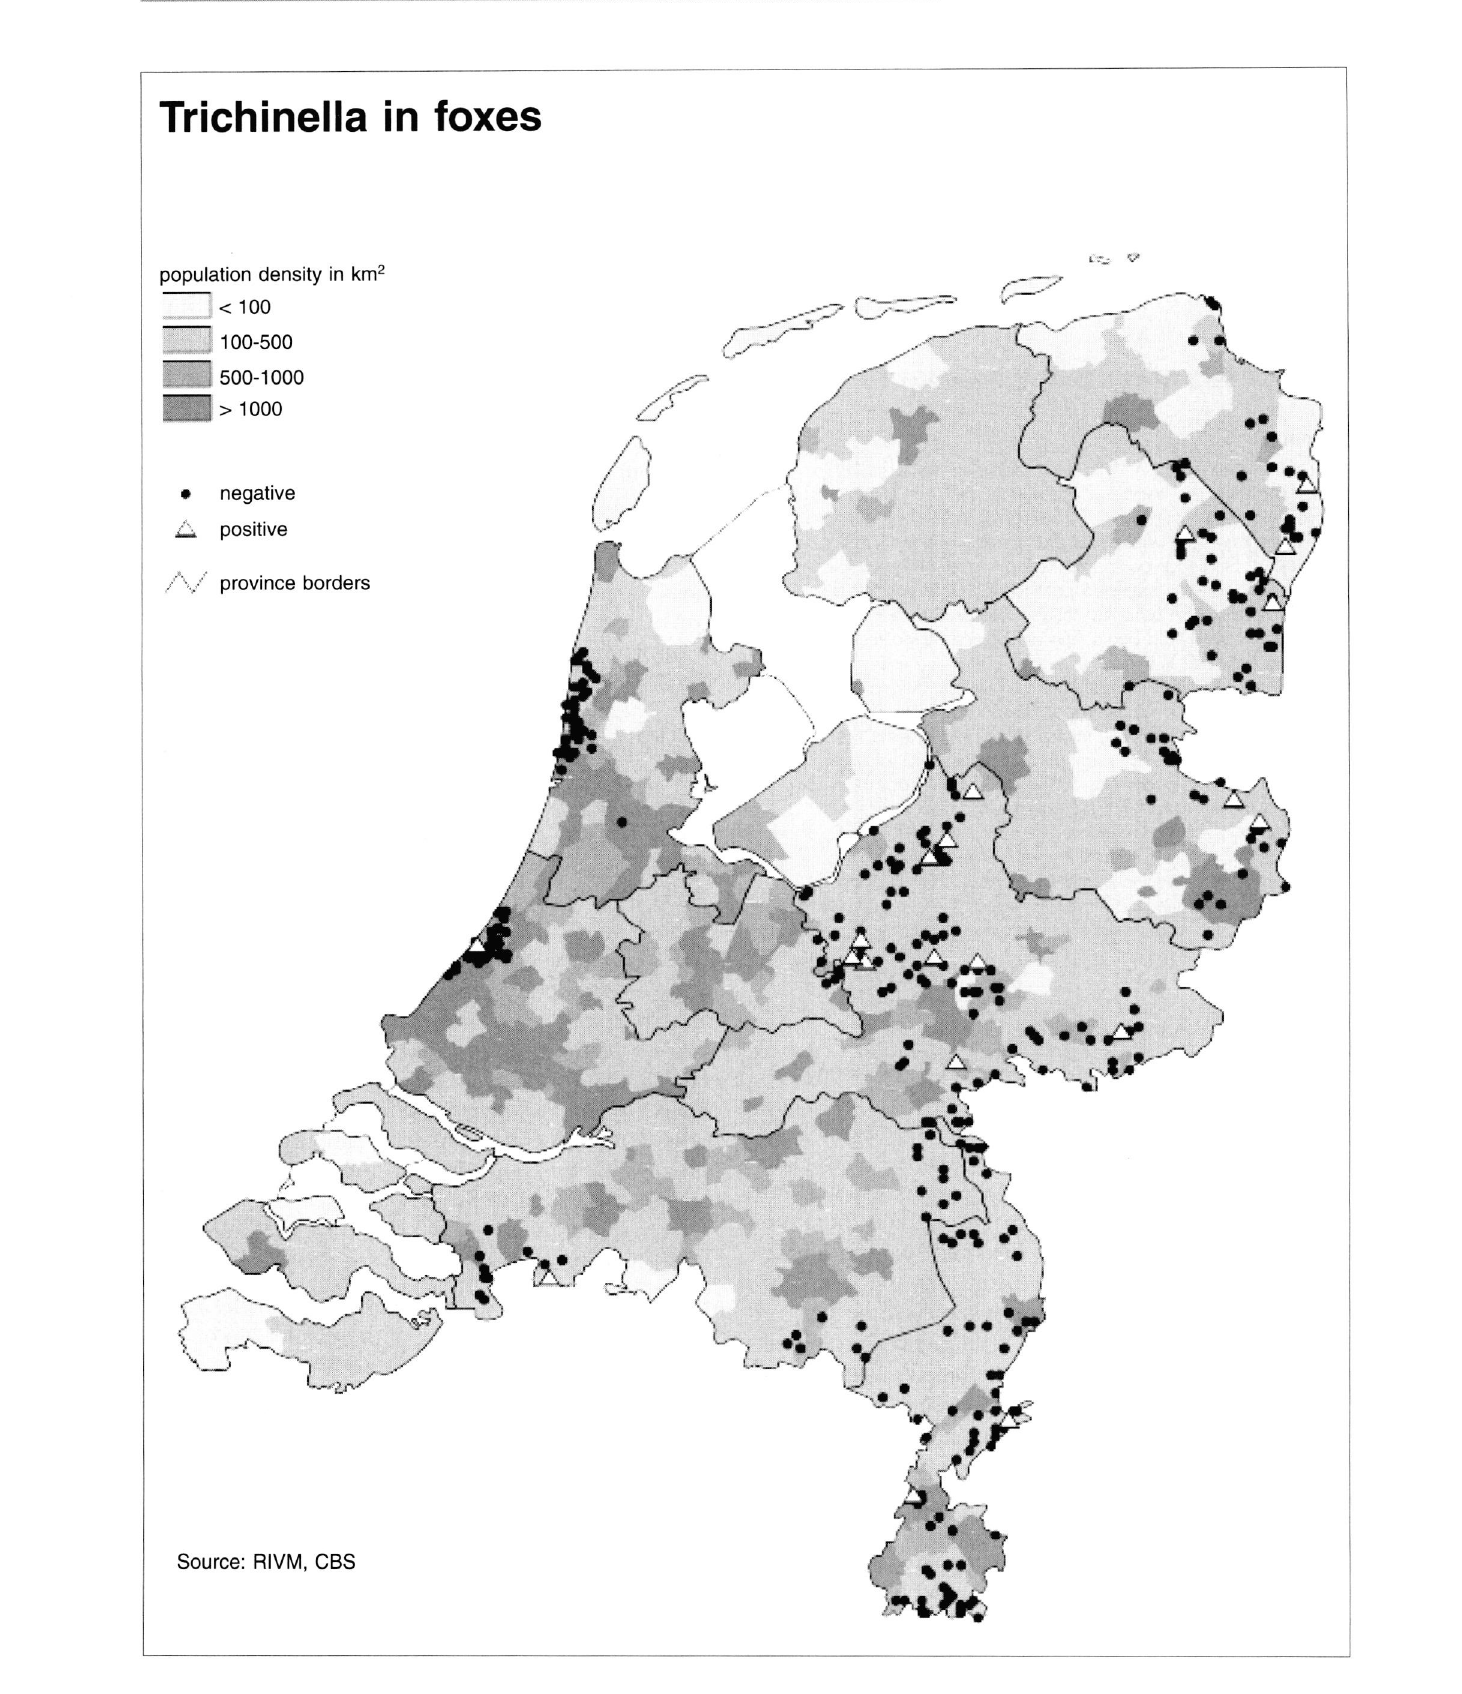
Fig. 1. - Spatial distribution of Trichinella in foxes in the Netherlands. Negative (•) and positive (A) Trichinella foxes as found in various regions in the Netherlands. The human population densities are marked on the